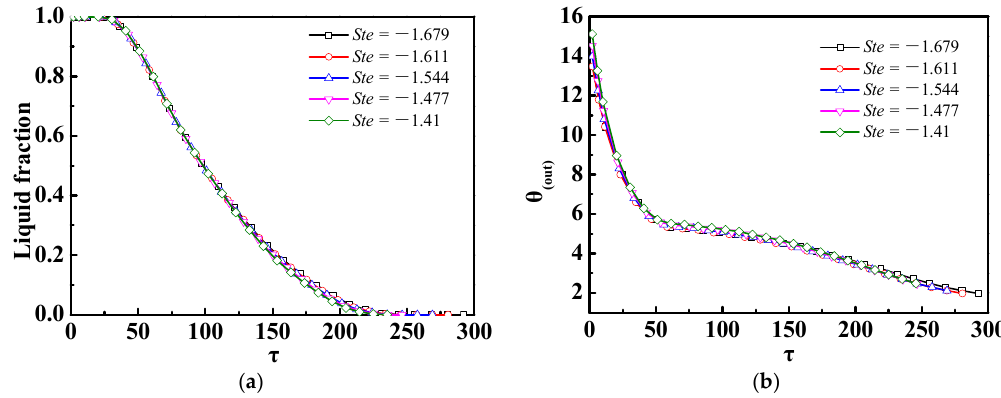
Figure 10. ( a ) Liquid fractions of the m-PCMs and ( b ) dimensionless outlet temperature as a function of dimensionless time at different Ste numbers.